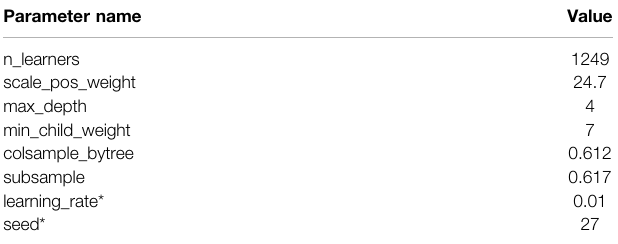
TABLE 4 | Final XGBoost model parameters used to train all models for analysis.